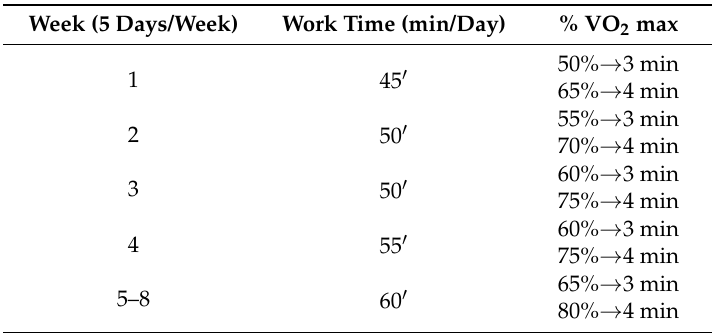
Table 2. Details of the aerobic interval training (AIT)